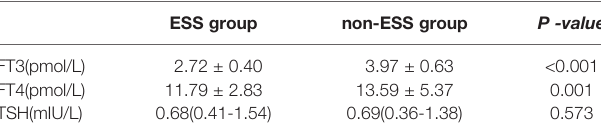
TABLE 2 | Comparison of thyroid hormone levels between ESS group and non- ESS